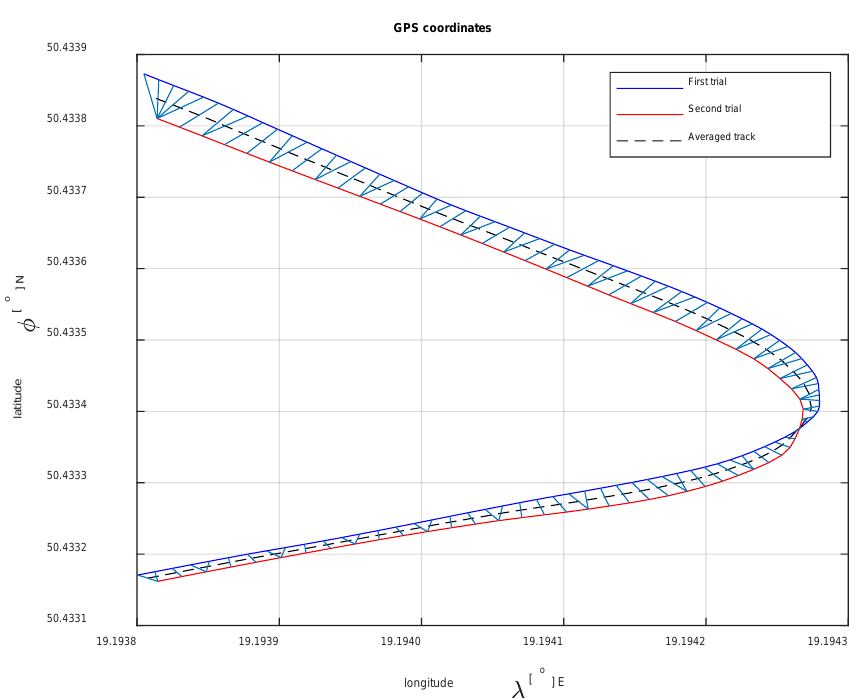
Figure 4. An example of determining the averaged track.